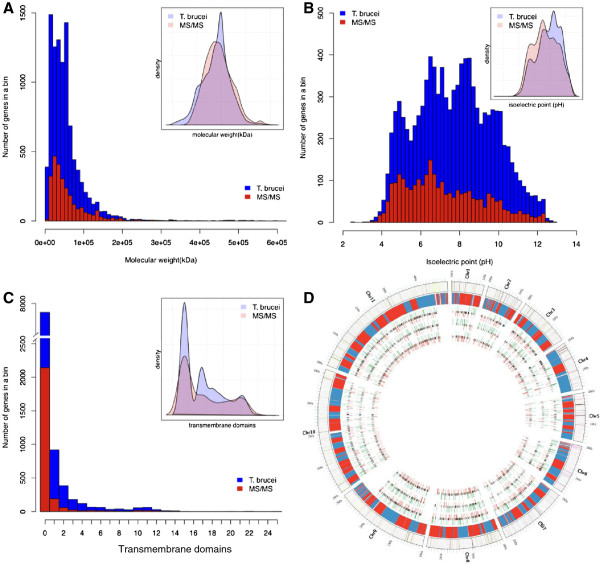
T.brucei proteome coverage using SILAC and mass spectrometry. Comparison of mass spectrometry and genome encoded proteome. (A) molecular weight, (B) isoelectric point and (C) transmembrane domains. Histograms depict the number of proteins of a certain class encoded in the genome (blue) and detected by mass spectrometry (red). The insets depict a density plot of the corresponding histogram indicating which regions are over/under represented when comparing genome and mass spectrometry. (D) Distribution of protein ratios from the three life stages of T. brucei across the 11 mega-chromosomes. From outside to inside, the chromosomes one to 11, the polycistronic transcription units (PTUs) on the chromosomes (red, PTU on sense strand; blue, PTU on antisense strand), protein ratios LS/PC, SS/LS, PC/SS (green, ≥ 2x up; red, ≥ 2x down; black unchanged).